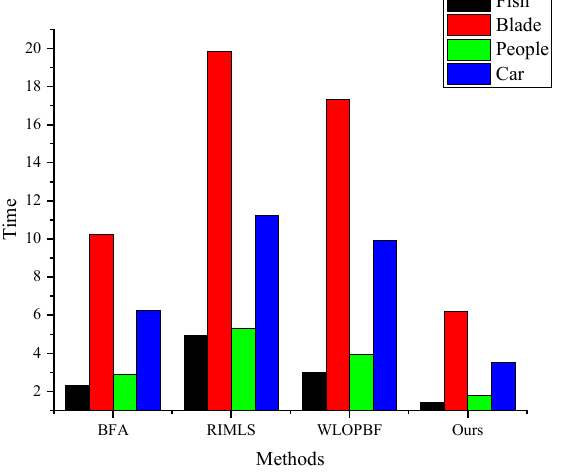
Figure 12. Running time of small-scale noise filtering methods.